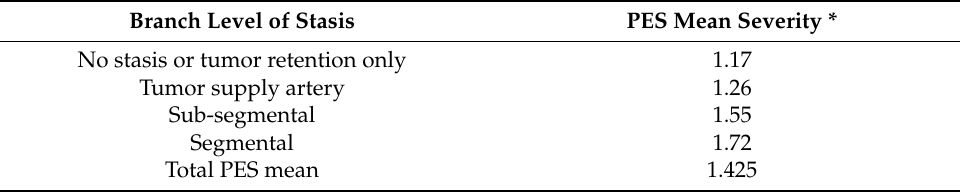
Table 4. Branch level of temporary stasis associated with mean severity of postembolization syn- drome (PES).